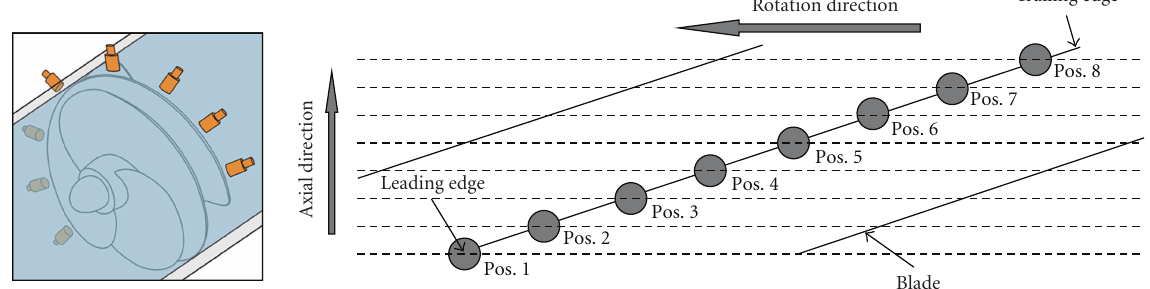
Figure 5: Location of pressure taps along the blade for measurements of unsteady pressure.